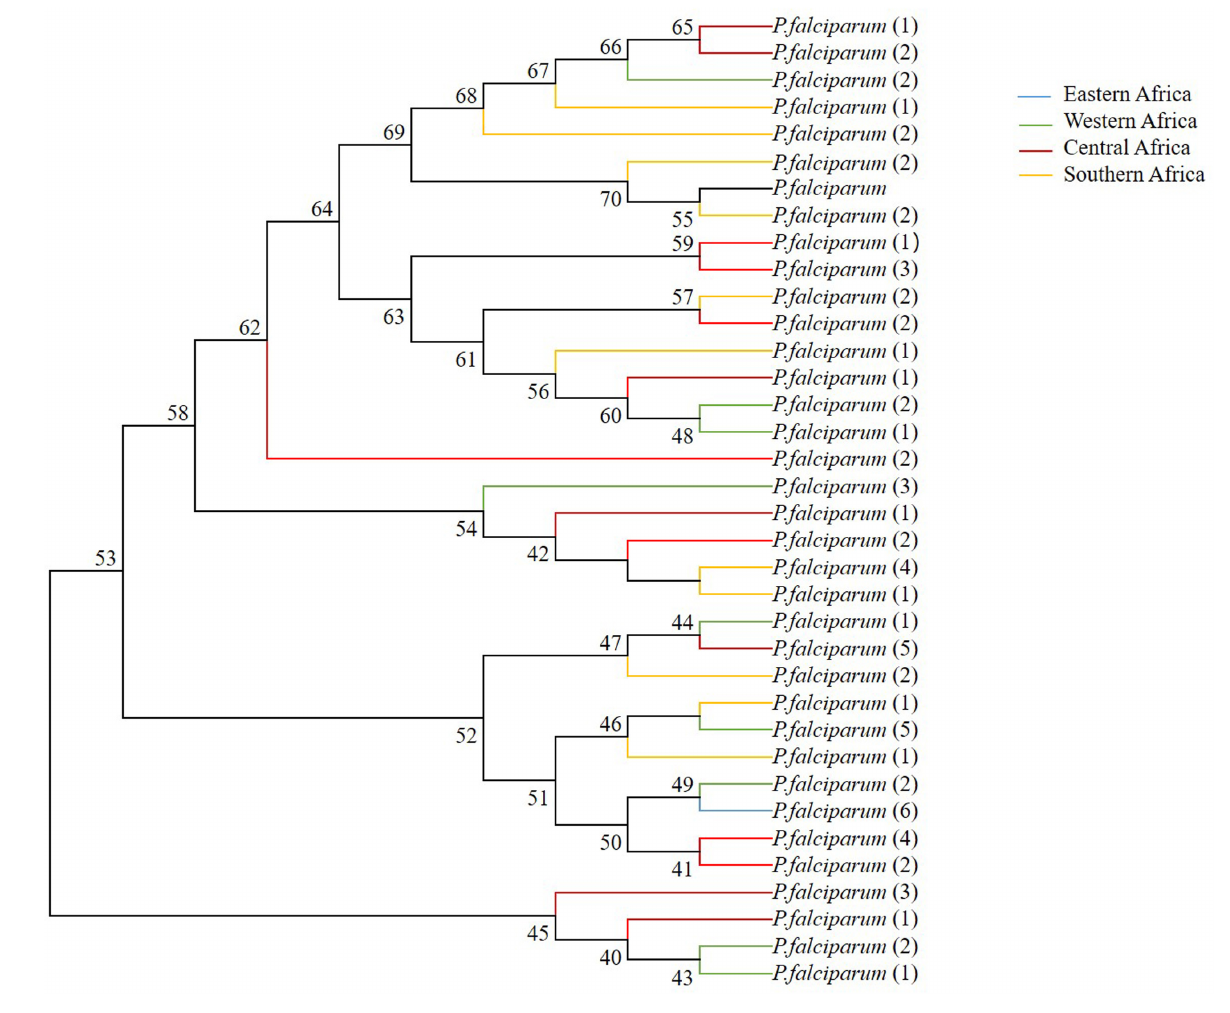
FIGURE 5 | Phylogenetic relationship of sra full-length genes within pfsra sequences based on the neighbor-joining method. Numbers at nodes show bootstrap